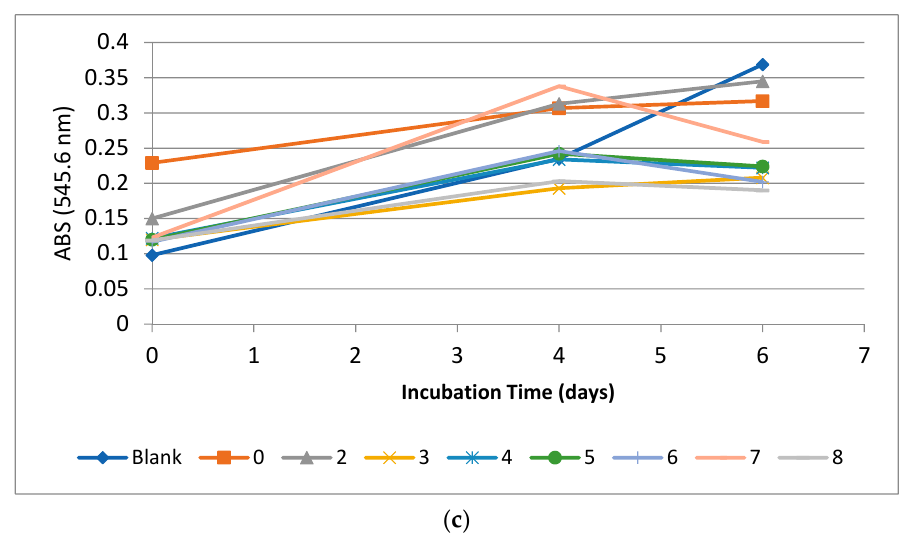
Figure 7. The absorbance values were recorded for the microalgae populations in contact with the various solutions (0–8) and for the control (blank) immediately after the preparation of the samples–algae mixture (incubation time = 0) and after 4 and 6 days. ( a ) TBA, ( b ) IMI, ( c ) AZO.